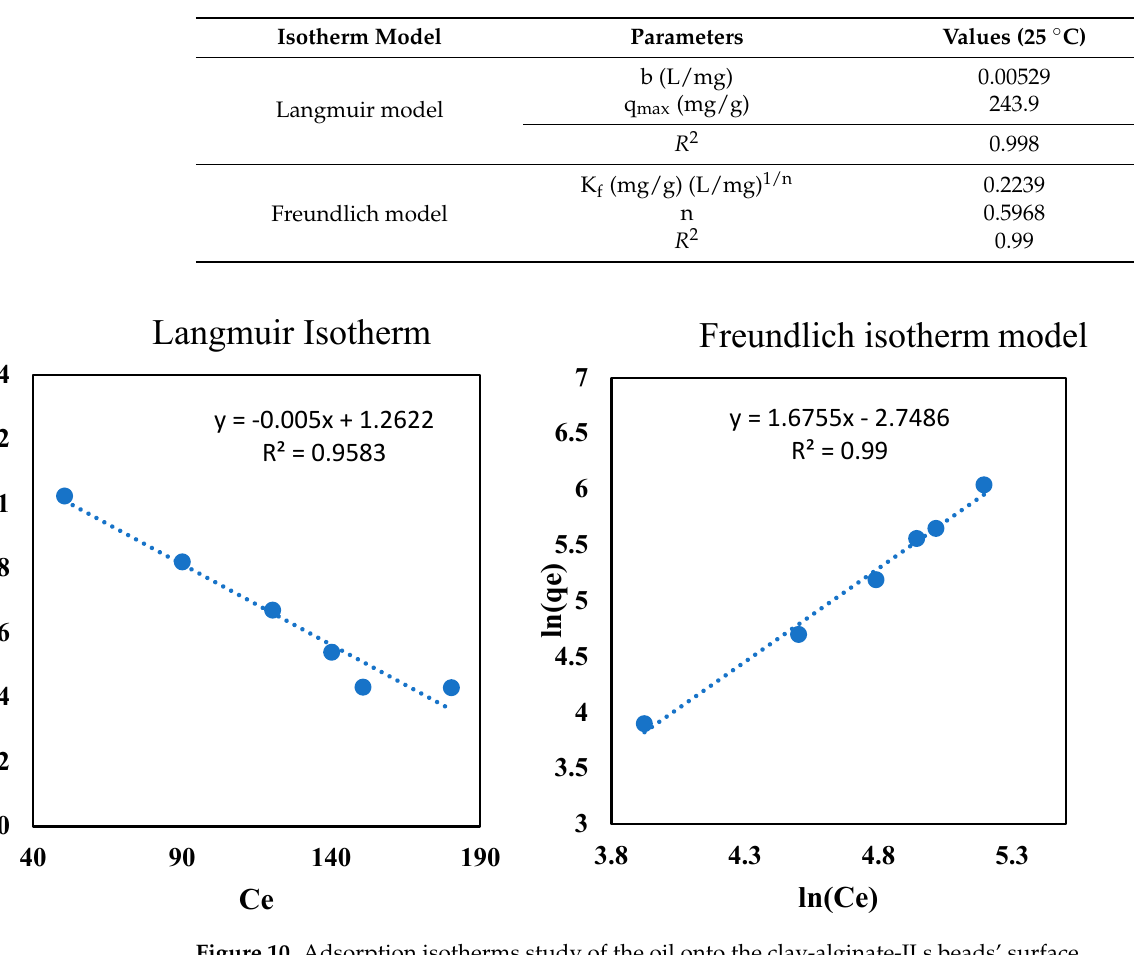
Figure 10. Adsorption isotherms study of the oil onto the clay-alginate-ILs beads’ surface. Table 2. Adsorption isotherm parameters of the oil adsorption into the beads.